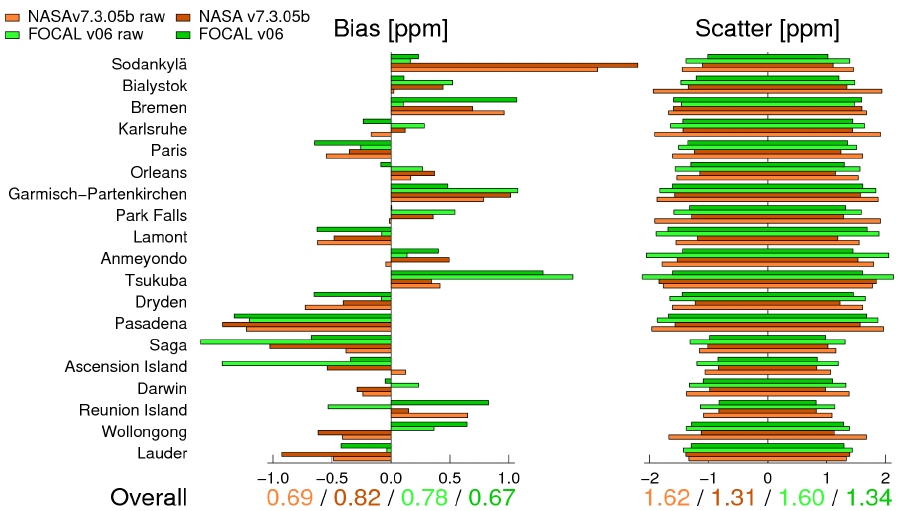
Figure 16. Validation statistics bias and scatter per TCCON site with more than 250 co-locations for FOCALv06 and NASA’s operational OCO-2 L2 product (both with and without bias correction). The summarizing values (“overall”) represent the standard deviation of the site biases and the average scatter relative to TCCON, respectively.The sites are ordered from north (top) to south